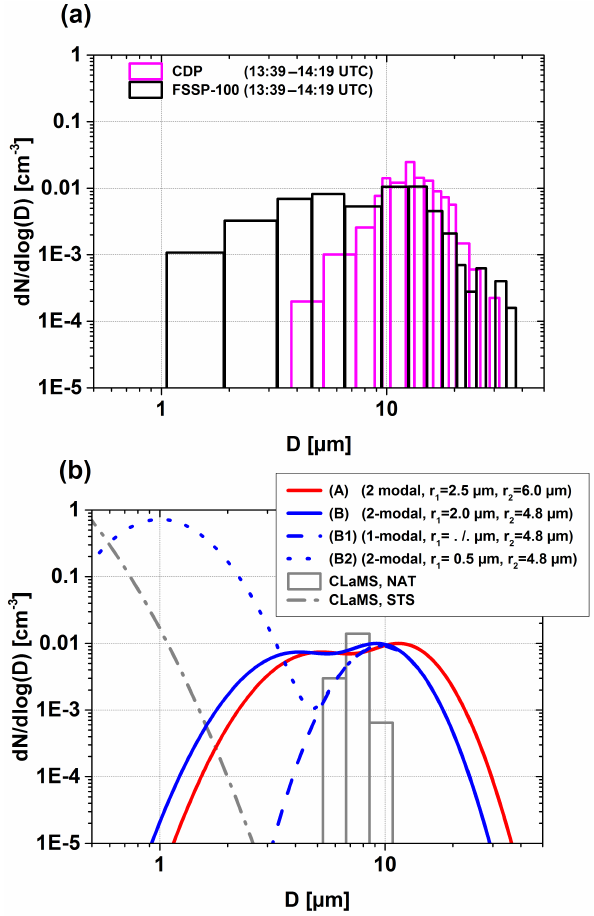
Figure 9. (a) Particle size distributions derived from the FSSP- 100 (black) and CDP (magenta) measurements during the PSC en- counter (from Molleker et al., 2014, Fig. 12). (b) Particle size distri- butions used in radiative transfer simulations of MIPAS-STR PSC spectra (red and blue) and simulated by the CLaMS (grey). Note that particle sizes are indicated in diameter ( D